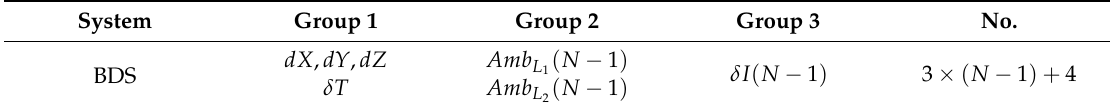
Table 2. The classify of the estimated parameters for DD baseline